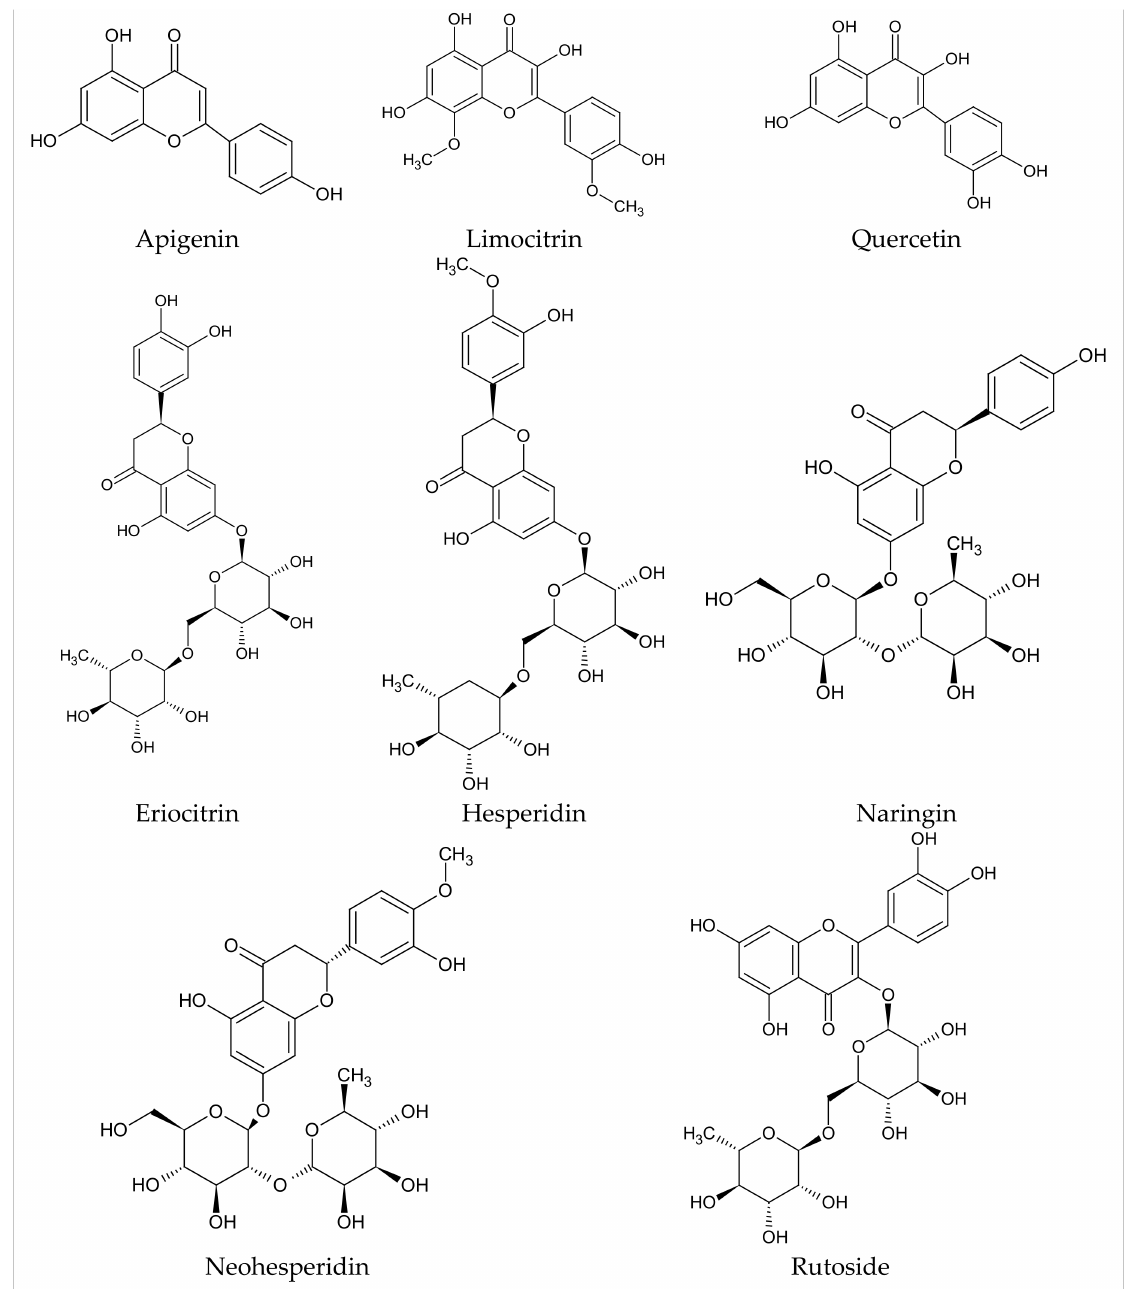
Figure 2. Chemical structure of flavonoids characteristic of C.